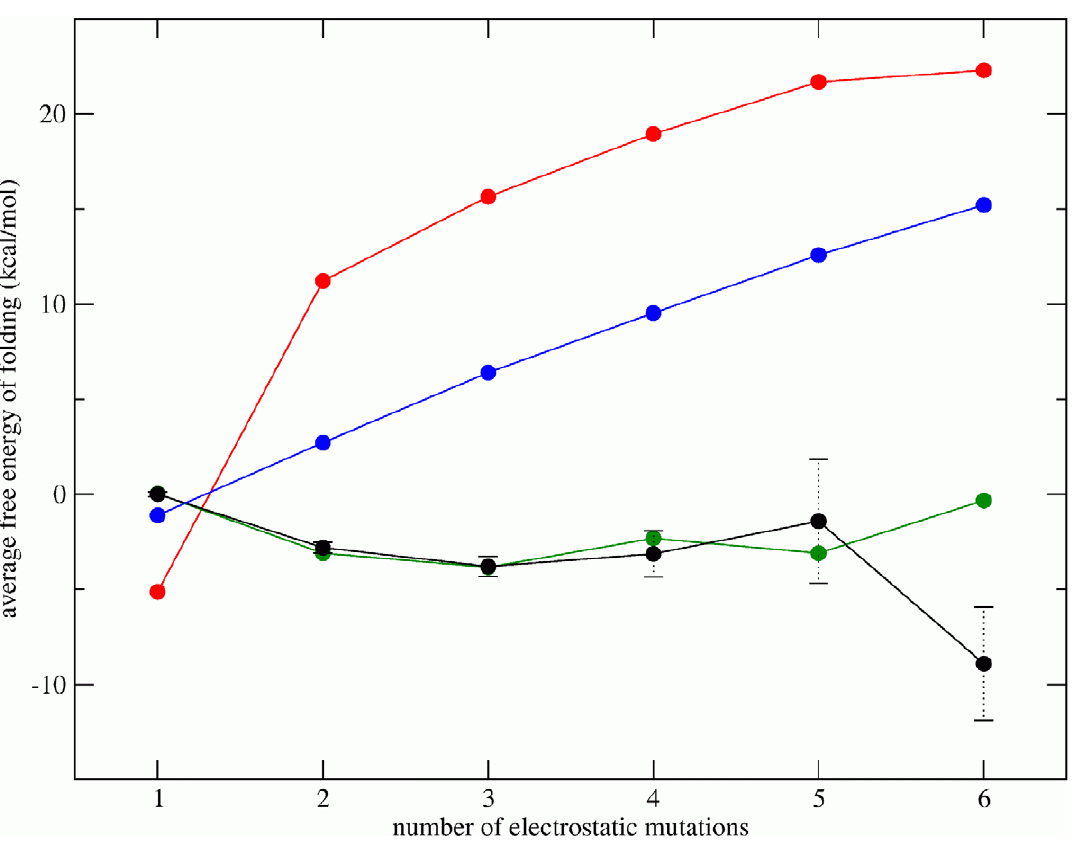
Figure 2. Average electrostatic free energy of folding as a function of the number of electrostatic mutations. Each point on a curve P n D G n , where N m is the number of sequences with m electrostatic mutations, P n is the probability of the n th sequence under a corresponds to P N m n ~ 1 e is its electrostatic folding energy (Equation (1); see Methods). All points are plotted given model conditional upon the number of mutations, and D G n e P n D G n relative to P N 1 , the average D G e of observed sequences with one electrostatic mutation. The black curve shows the average energies of e n obs ~ 1 = N m ) , the red curve represents the average energies of sequences under a model in which each charge state occurs observed sequences ( P n obs with equal frequency, the blue curve shows the average energies of sequences under a model in which each charge state occurs with frequencies observed in the data, and the green curve represents the average energy of sequences under a pair correlation model which preserves observed pair frequencies. The error bars on the black curve are the standard errors of the mean of observed sequences. Note that N m ~ f 13470,4798,1515,337,50,11 g for m ~ 1 ... 6 . separate database, the drug-annotated Stanford database which contains HIV protease subtype B sequences from various sources [31]. Figure 3 plots the probabilities of sequences using the pair correlation model, P 2 , as a function of the observed probabilities in the Lee database. Sequences are also shaded according to a gradient that represents how often the sequence occurs in the Stanford database, relative to the Lee database. The plot shows that sequences with the highest predicted P 2 probabilities that are unobserved in the Lee database are largely shaded red, indicating that most are observed in the Stanford database. In fact, of the top 25 most probable sequences predicted by the pair correlation model that are not found in the Lee database, 19 are present in the Stanford database (Table S2). Most of these sequences are also significantly associated with drug therapies (e.g. p v 0 : 05 ). As the predicted P 2 probability decreases, the shading of the dots gradually changes to green, indicating that sequences with the lowest predicted P 2 probabilities are unobserved in both the Lee and the Stanford database. Thus our approach exhibits consid- erable predictive power. If we examine other sequences in the tail of the Lee probability distribution that are observed once, twice, three times etc in the Lee database, we notice a similar trend;